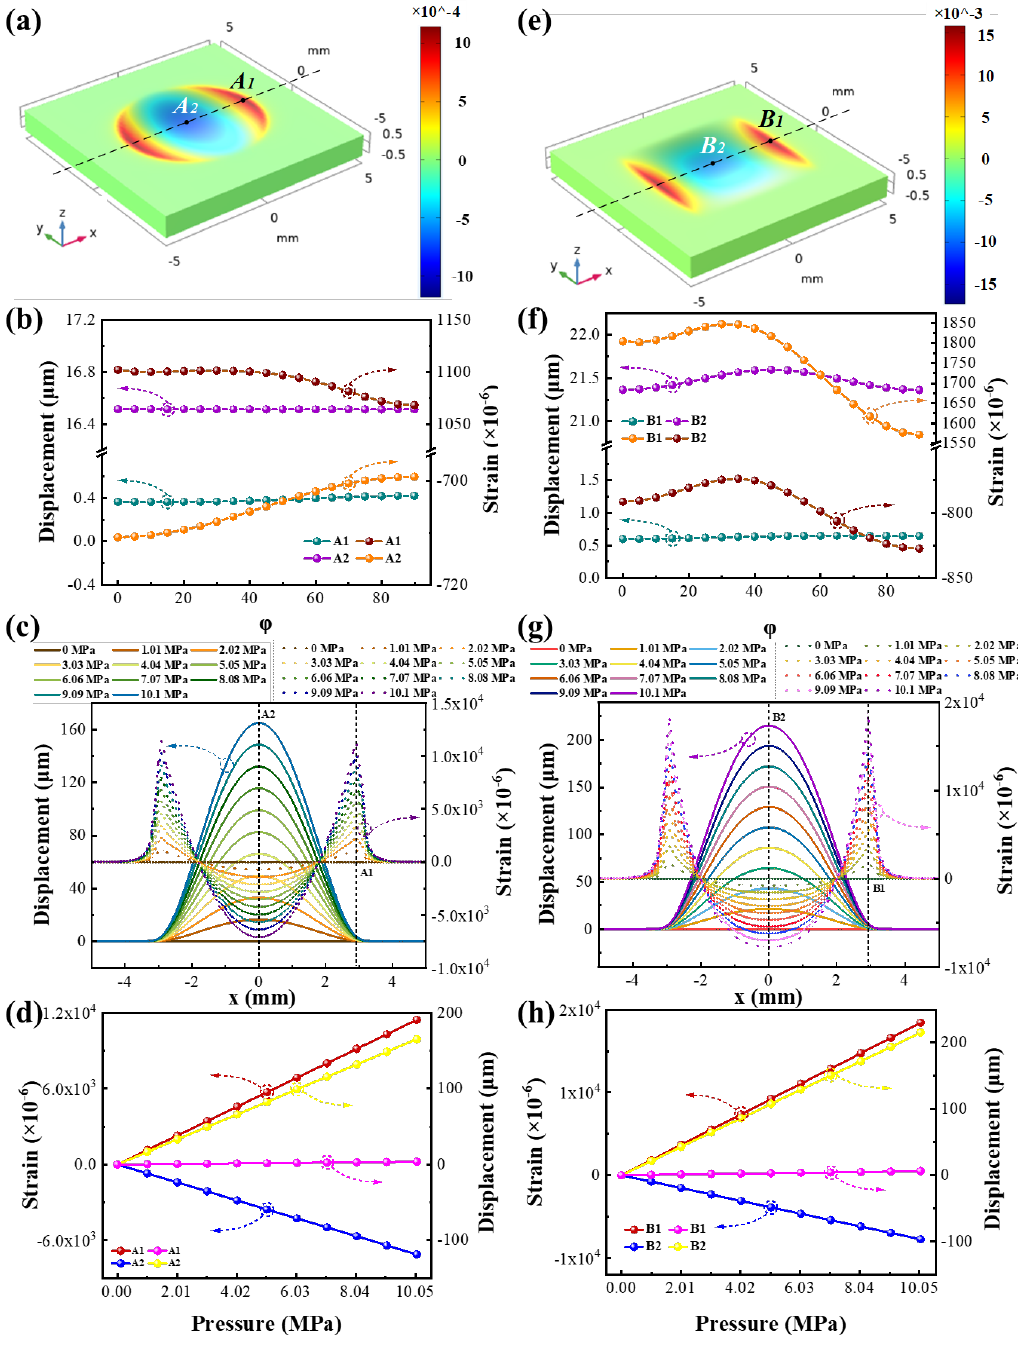
Figure 4. ( a ) Strain distribution in the direction of ϕ = 0 ◦ of column cavity with pressure = 1.01 MPa. ( b ) The relationship between the strain and displacement at A1 and A2 as a function of ϕ , pressure = 1.01 MPa. ( c ) Curve of strain and displacement of column cavity in the direction of ϕ = 0 ◦ as a function of pressure. ( d ) The displacement and strain ( ϕ = 0 ◦ ) of A1 and A2 under different pressures. ( e ) Strain distribution in the direction of ϕ = 0 ◦ of cuboid cavity with pressure = 1.01 MPa. ( f ) The relationship between the strain and displacement at B1 and B2 as a function of ϕ , pressure = 1.01 MPa. ( g ) Curve of strain and displacement of cuboid cavity in the direction of ϕ = 0 ◦ as a function of pressure. ( h )The displacement and strain ( ϕ = 30 ◦ ) of B1 and B2 under different